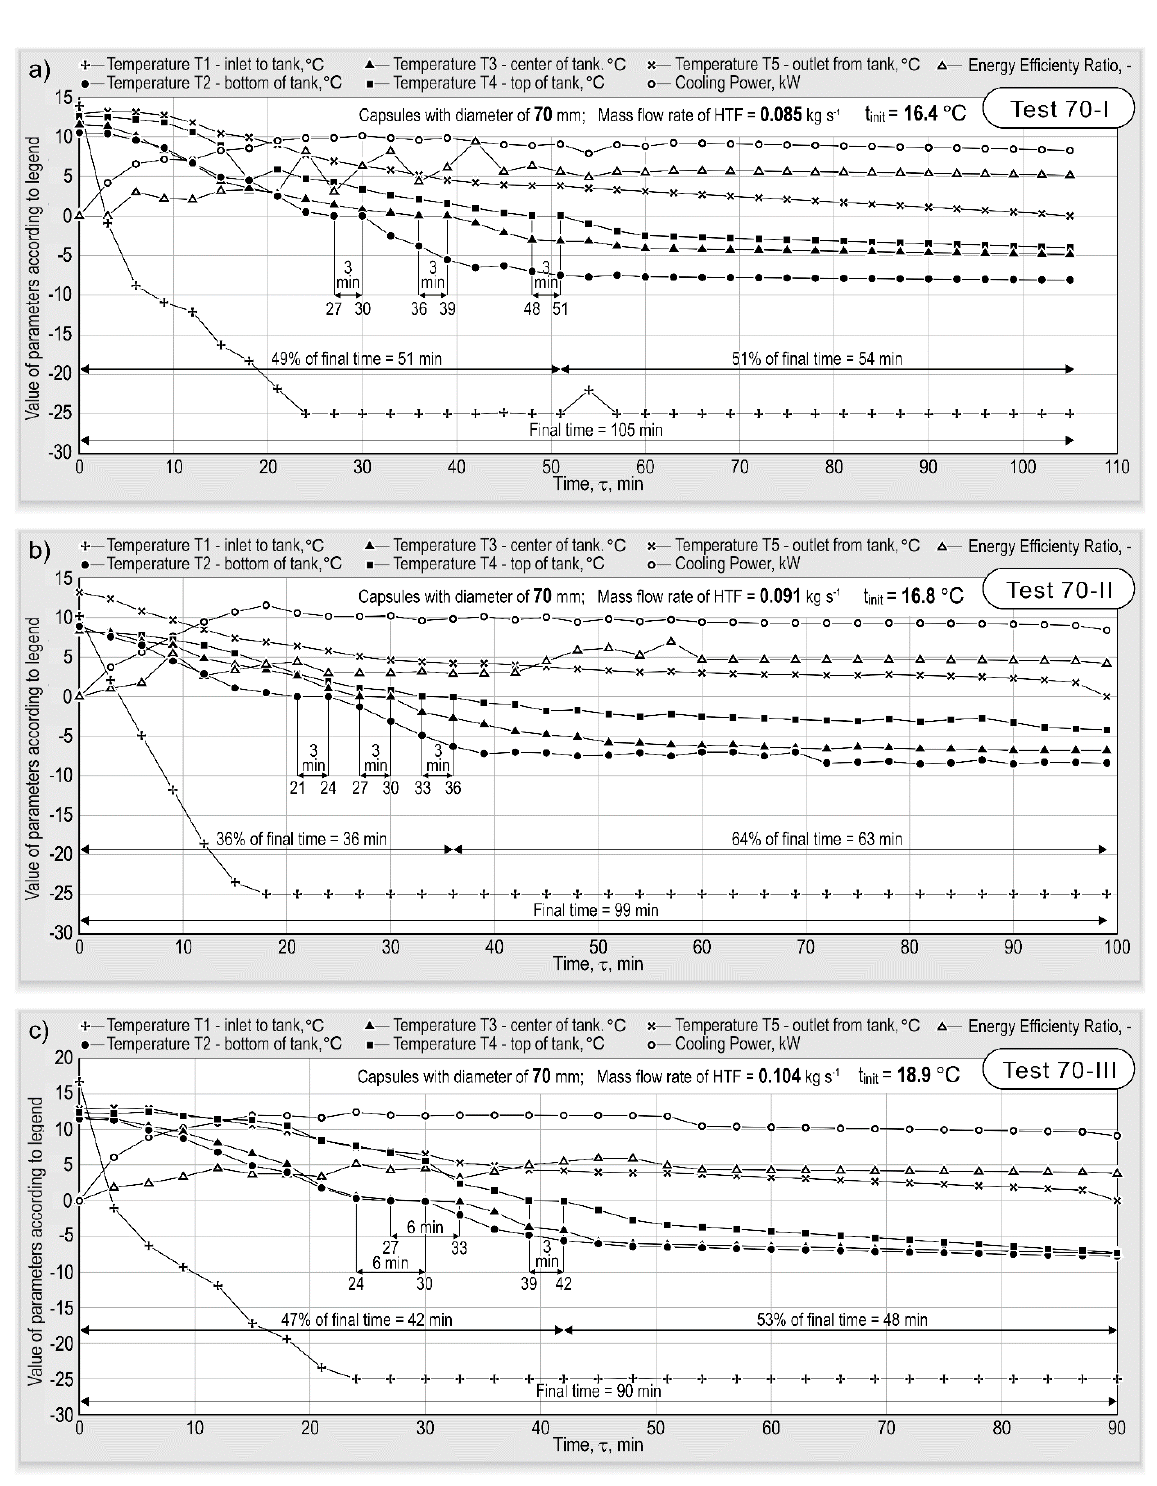
Figure 5. Measurement results: distribution of temperatures, cooling power, and energy efficiency ratio as a function of time for 70-mm-diameter capsules: ( a ) Test 70-I; ( b ) Test 70-II; ( c ) Test 70-III. In the case of 60-mm-diameter capsules, their smaller mass compared to 70- and 80- mm-diameter capsules made the bed more prone to vibration during the flow of the heat transfer fluid. For 60-mm-diameter spheres, the increase in HTF mass flow rate up to me- dium and high levels caused intensive vibrations of the capsules. The increase in flow, combined with the intensive vibrations of 60-mm-diameter capsules, did not allow for the thermal stratification of the bed at the time of the water – ice phase change. Strong